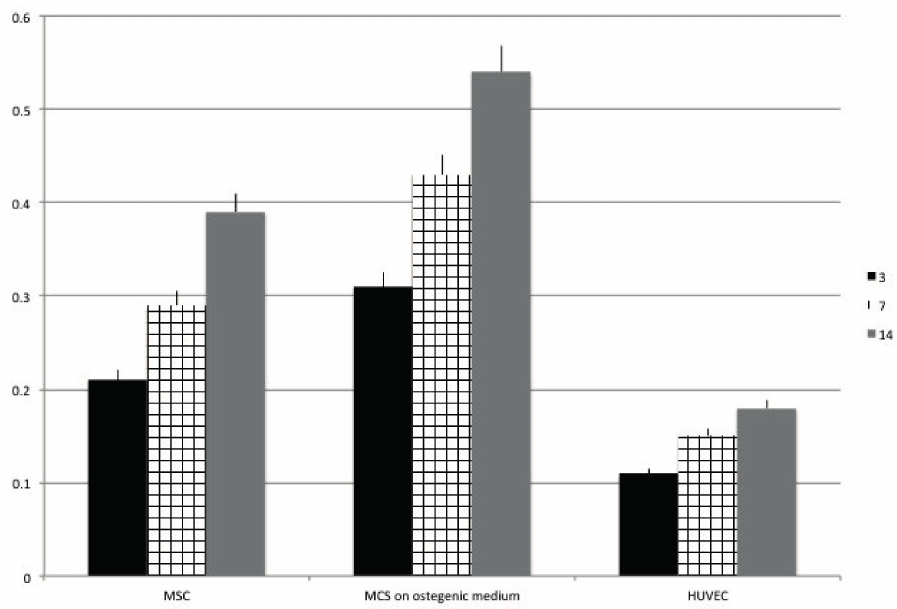
Figure 6. Analysis of ALP activity after 3 (black bars), 7 (squared bars), 14 (grey bars) days of culture onto OGI surfaces of MSC cultured in presence of nondifferentiative medium, osteoinductive medium;